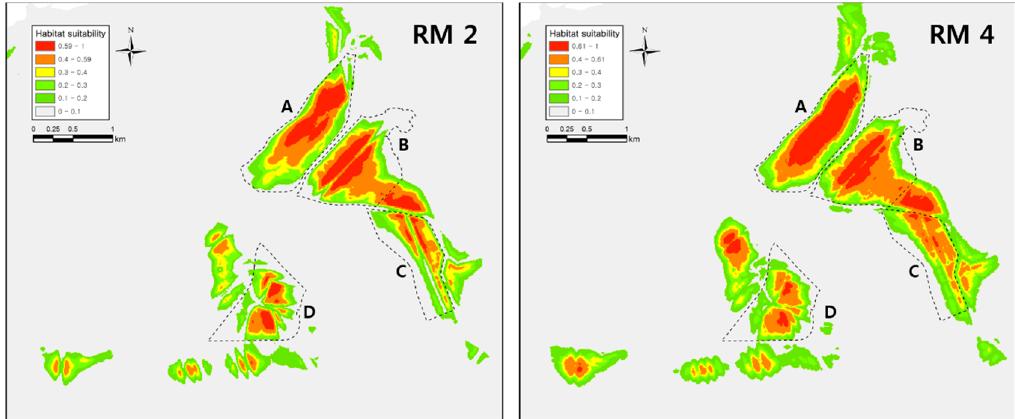
Figure A1. Dryophytes suweonensis SDM results using RF (random forest) and BRT (boosted regression trees). These results follow an applied average suitability approaches to designate a threshold for D. suweonensis habitability suitability. RF and BRT show that site B mainly is suitable to D. suweonensis .